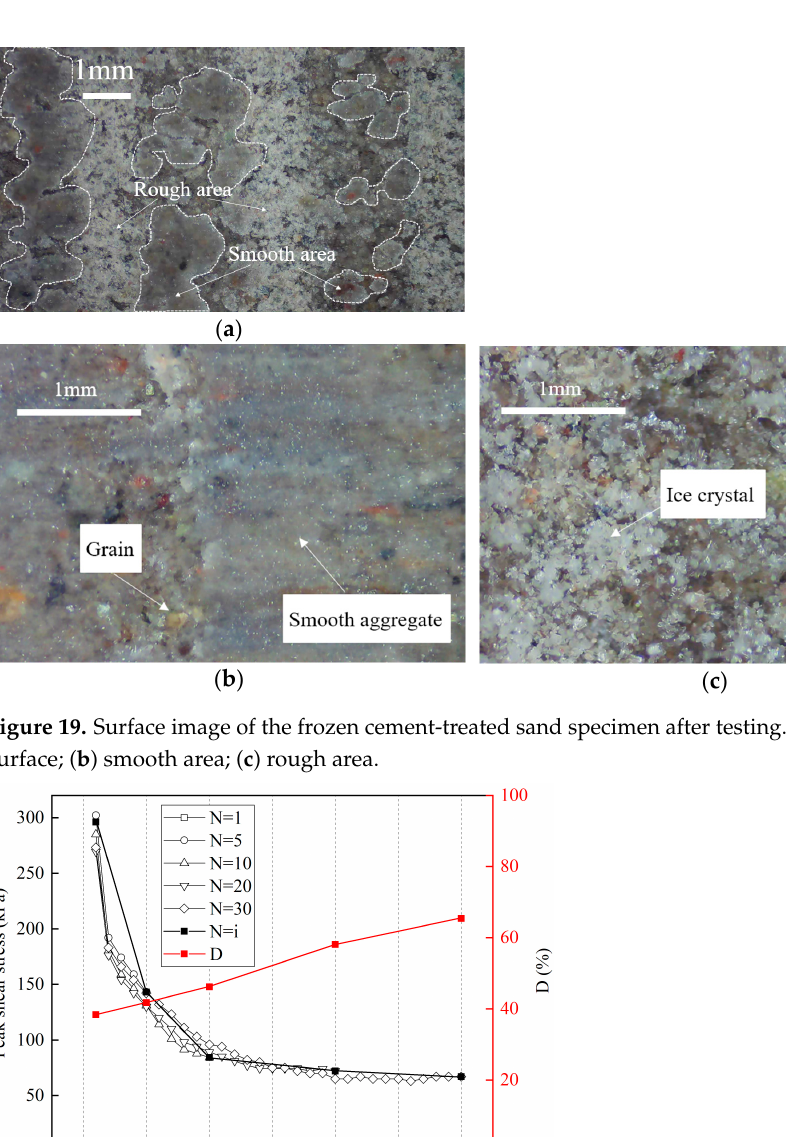
Figure 19. Surface image of the frozen cement-treated sand specimen after testing. ( a ) Division of Figure 18. Surface image enhancement for frozen cement-treated sand specimens after testing at the the surface; ( b ) smooth area; ( c ) rough area. different number of cycles. ( a ) Example of surface image enhancement for a frozen cement-treated sand specimen after testing; ( b ) Surface image enhancement for different number of cycles with T = − 10 °C, σ N = 300 kPa.